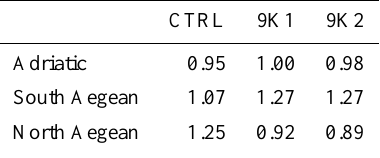
Table 2. Index of Stratification (IS, in m 2 s − 2 ).